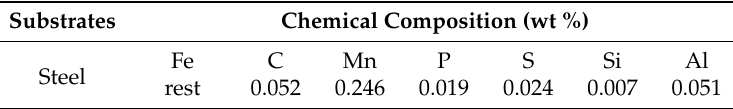
Table 4. Chemical composition of the steel substrates.